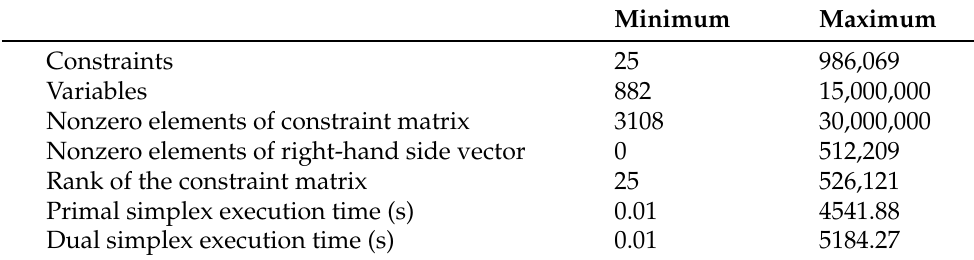
Table 1. Lower and upper values of examined LP